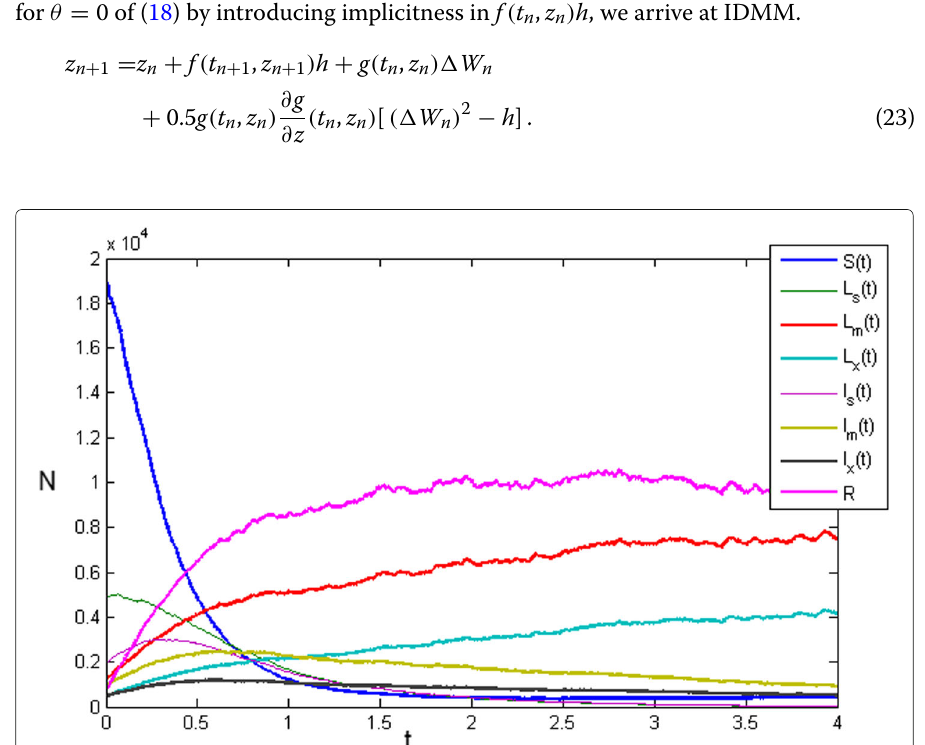
for θ = 0 of (18) by introducing implicitness in f ( t n , z n ) h , we arrive at IDMM.